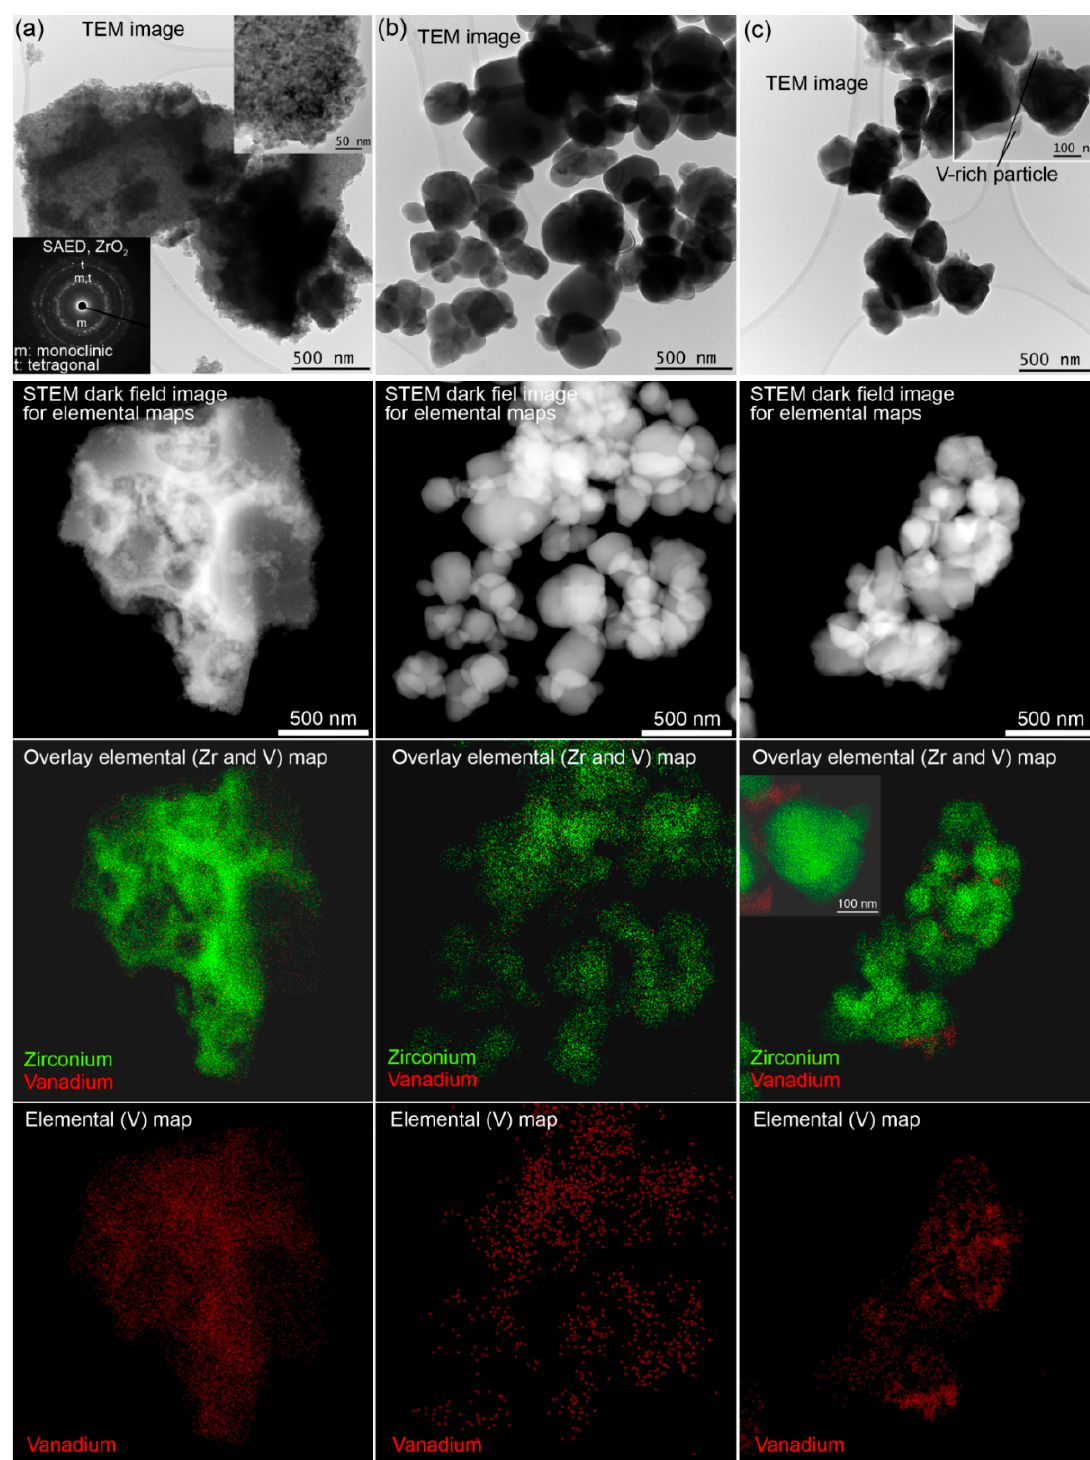
Figure 2. Analytical (S)TEM analysis of VZr catalysts. ( a ) 4VZr SG, ( b ) 3VZr Imp, and ( c ) 3VZr Imp 500 ° C.